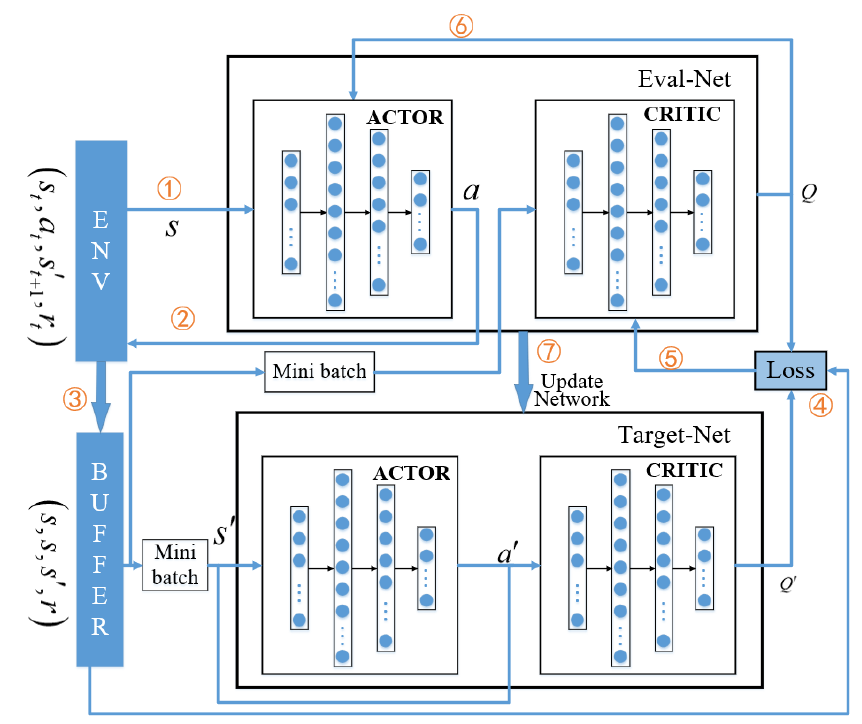
Figure 2. Convergence property of different